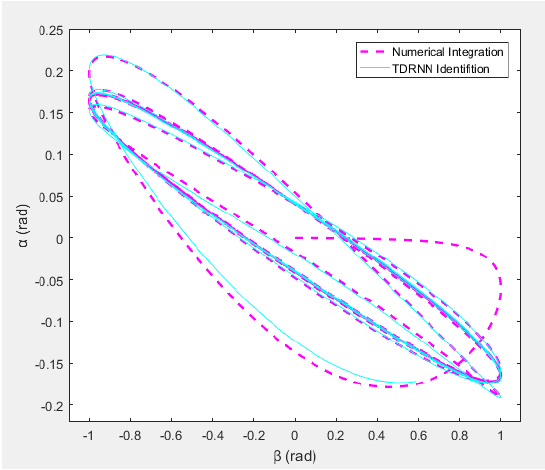
Figure 10. Input – output characteristic of the aeroelastic system with friction nonlinearity.